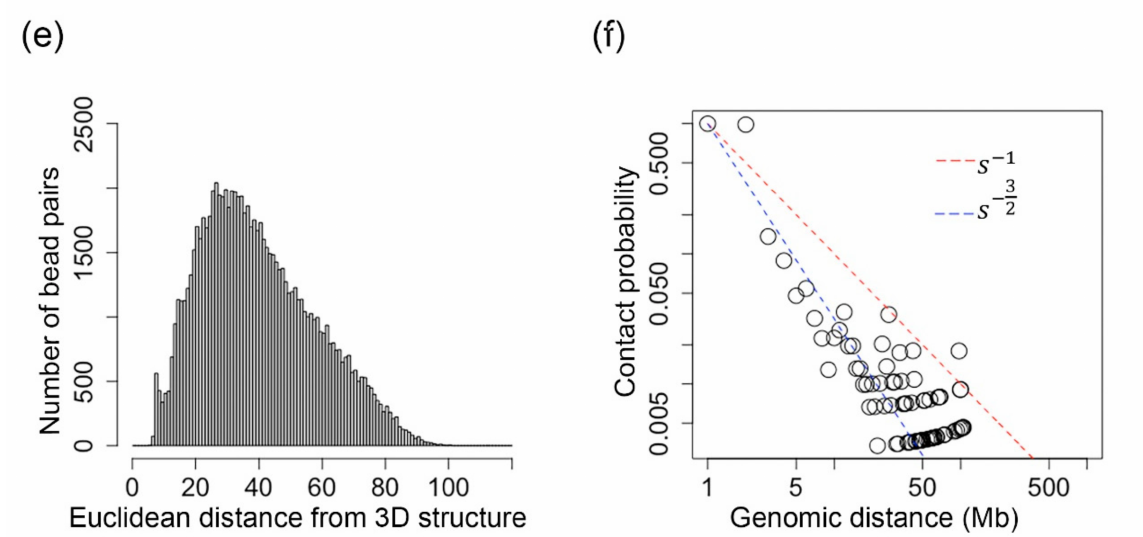
Figure 6. ( a ) The inferred 3D structure of the chromosome 3 of a mouse oocyte cell at 500 kb resolution. ( b ) Each black dot indicates one single-cell Hi-C contact. The darker orange color indicates higher Euclidean distances parsed from the inferred 3D structure, and the white color indicates small Euclidean distances parsed from the inferred 3D structure. ( c ) The distribution of the number of bead pairs over different values of Euclidean distances parsed from the inferred structure when θ i,j = 1. ( d ) The distribution of the number of bead pairs over different values of Euclidean distances parsed from the inferred structure when θ i,j ∈ ( 0.7, 1 ) . ( e ) The distribution of the number of bead pairs over different values of Euclidean distances parsed from the inferred structure when θ i,j ∈ ( 0, 0.7 ] . ( f ) The contact probability of bead pairs over different values of genomic